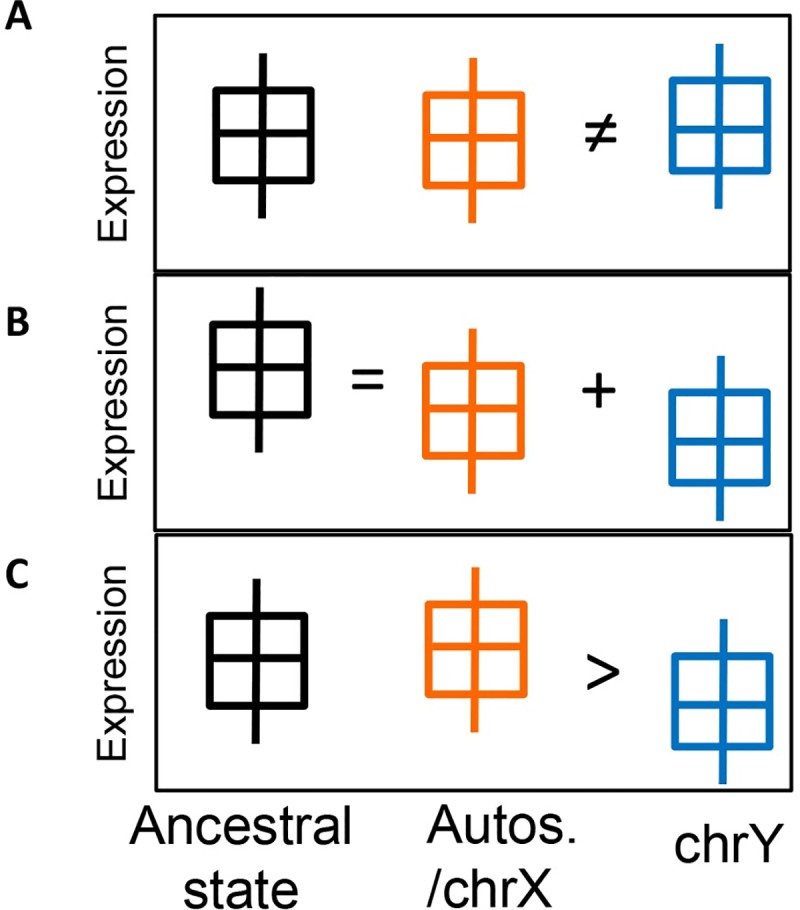
Possible differences in expression between Y ampliconic genes and their non-Y homologs.(A) Neo-functionalization: Ampliconic gene family, after moving to Y or divergence from the X, obtained a new beneficial function. The gene family might be under positive selection and its expression might be independent from its non-Y homolog. (B) Sub-functionalization: Ampliconic gene family, after moving to the Y or divergence from the X, acquired a (testis-specific) sub-function. Because sub-functionalization is division of labour, the sum of ampliconic gene expression and non-Y homolog expression should be equal to the ancestral expression. The average expression of ampliconic gene family could be lower or higher than that of their homologs and depends on the subfunction. (C) Relaxed selection: Ampliconic gene family, due to its multi-copy nature and presence of gene conversion, evolves at a faster rate than its non-Y homolog and is not under selection.